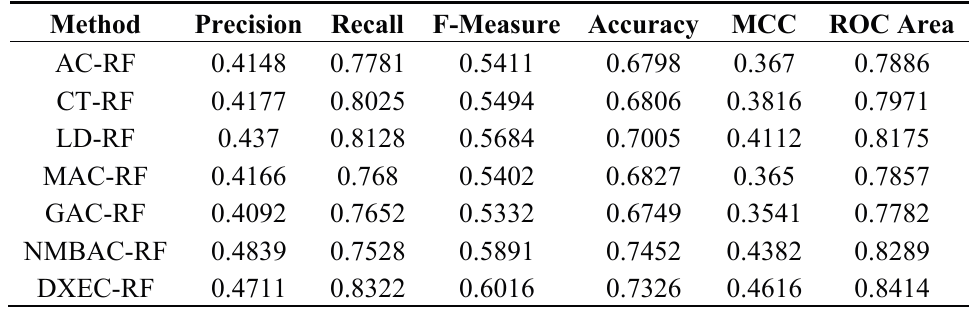
Table 3. Performance comparison of seven methods on the Human All dataset by using the Gold Human model.